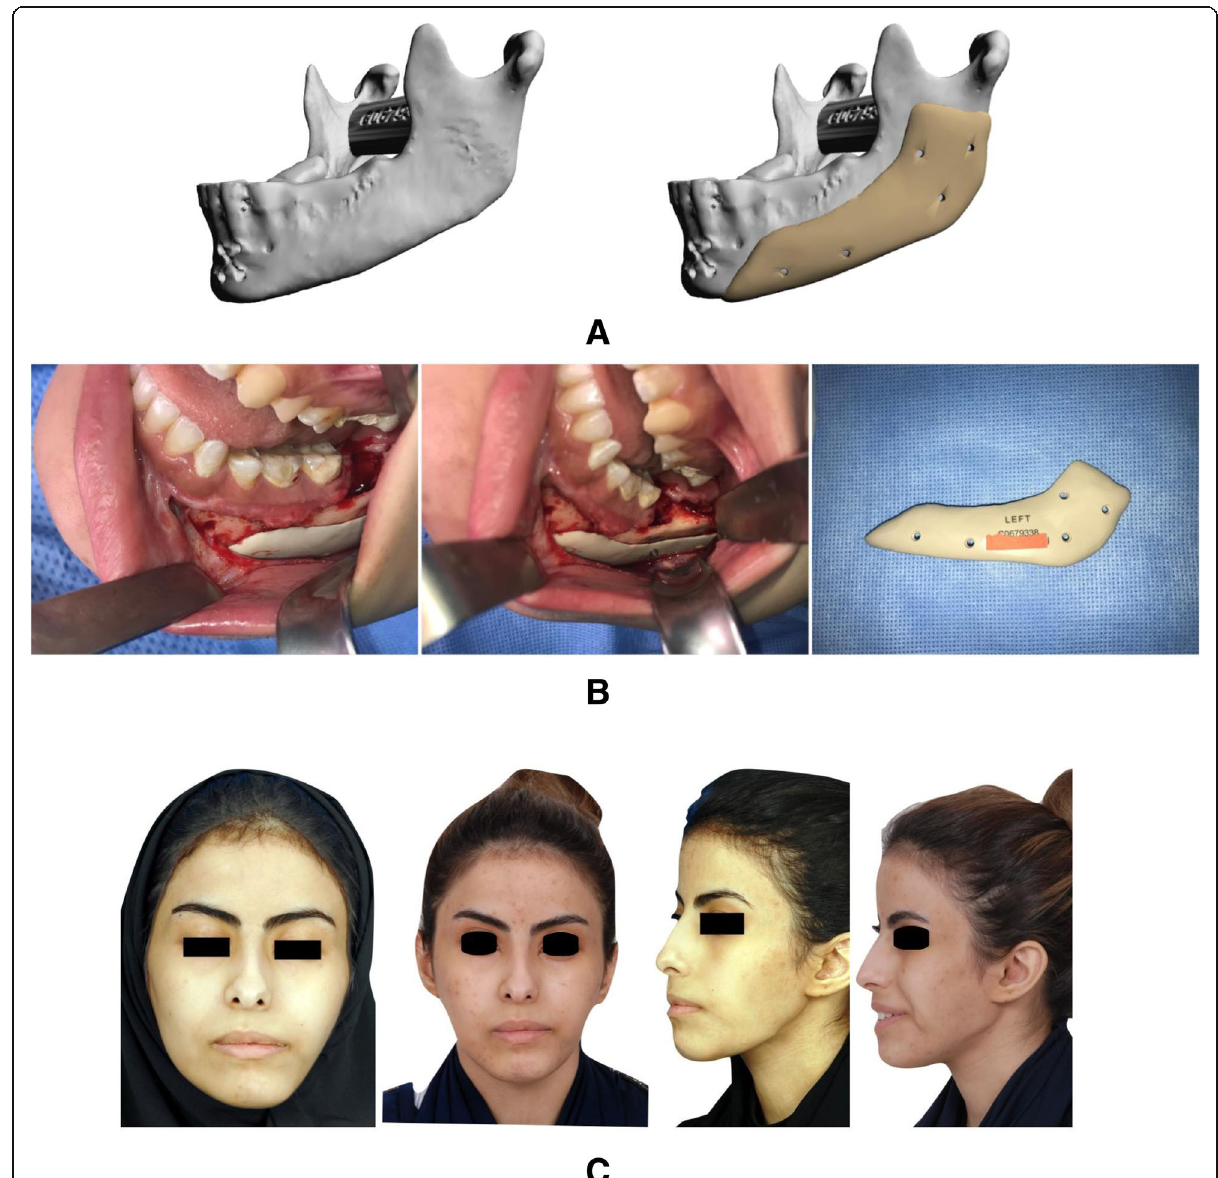
Fig. 2 Hemifacial microsomia case. a 3D reconstruction of CT showing defect and planned implant. b Intraoperative view of the implant. c